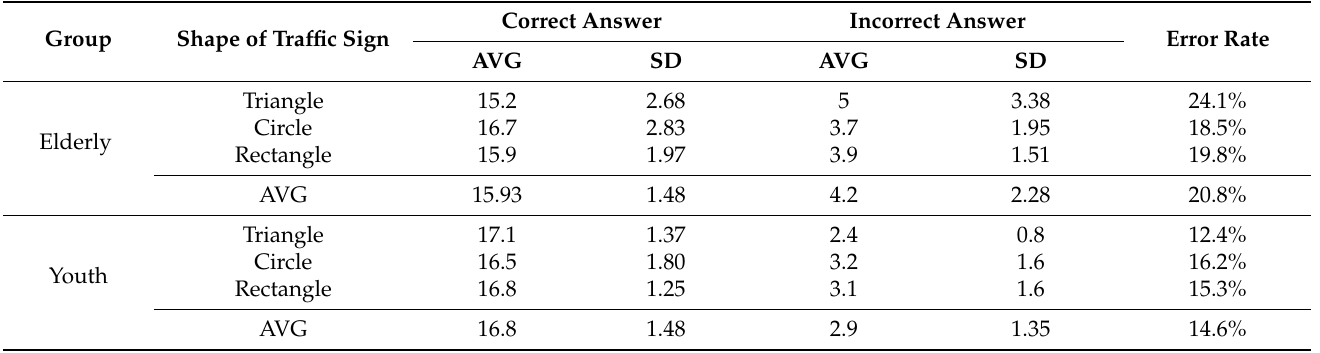
Table 2. Correct answer/incorrect answer rate for each traffic sign. Elderly subjects had a high percentage of incorrect answers, especially for the triangular sign.